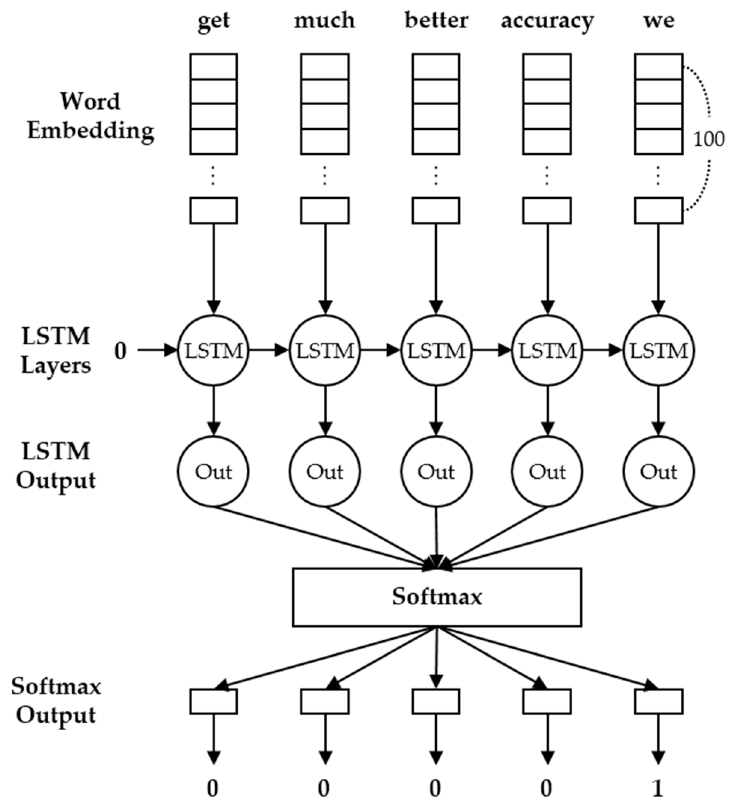
Figure 3. Schematic of the program to learn and generating period using Word2Vec and LSTM.